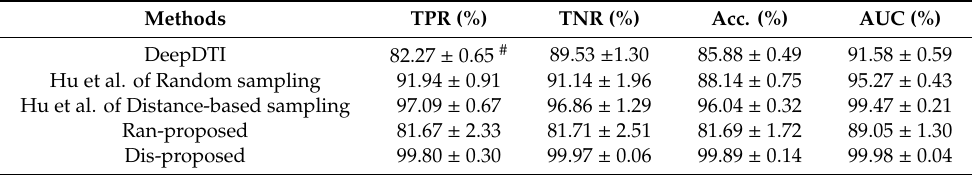
Table 3. Comparison with DeepDTI and Hu et al. Ran-proposed and Dis-proposed represent the methods based on random sampling and distance-based sampling for negative DTIs. TPR, TNR, Acc. and AUC represent True Positive Ratio, True Negative Ratio, Accuracy and Area Under ROC-curves.